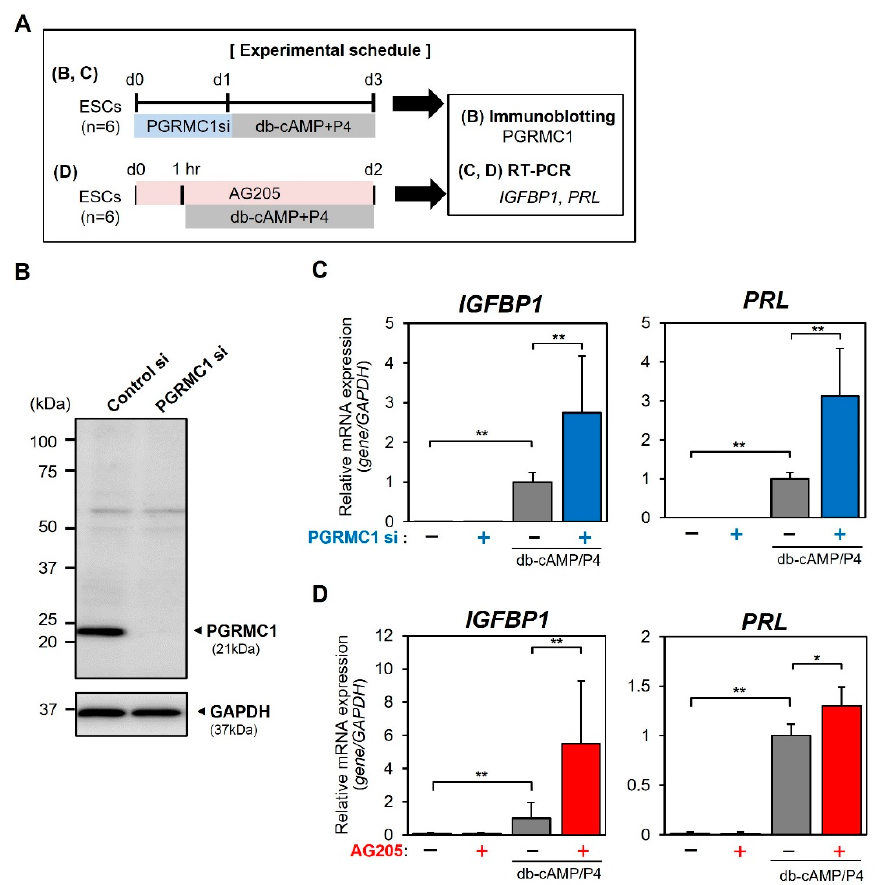
Figure 3. Effects of PGRMC1 knockdown and inhibition on db-cAMP/P4-induced decidualization. ( A ) Experimental schedules. ( B ) ESCs were transfected for 1 day with non-targeting control or PGRMC1-specific siRNA and cultured for an additional 2 days. Immunoblot analysis of PGRMC1. ( C ) The siRNA-transfected cells were stimulated with db-cAMP/P4 for 2 days. ( D ) Cells were treated for 1 h with the PGRMC1 inhibitor AG-205 and then stimulated with db-cAMP/P4 for 2 days. ( C , D ) Total RNA was subjected to real-time RT-PCR analysis to determine the expression levels of IGFBP1 and PRL . GAPDH was used as an internal control. Data represent the mean ± SEM of three independent experiments. * p < 0.05, ** p < 0.01.